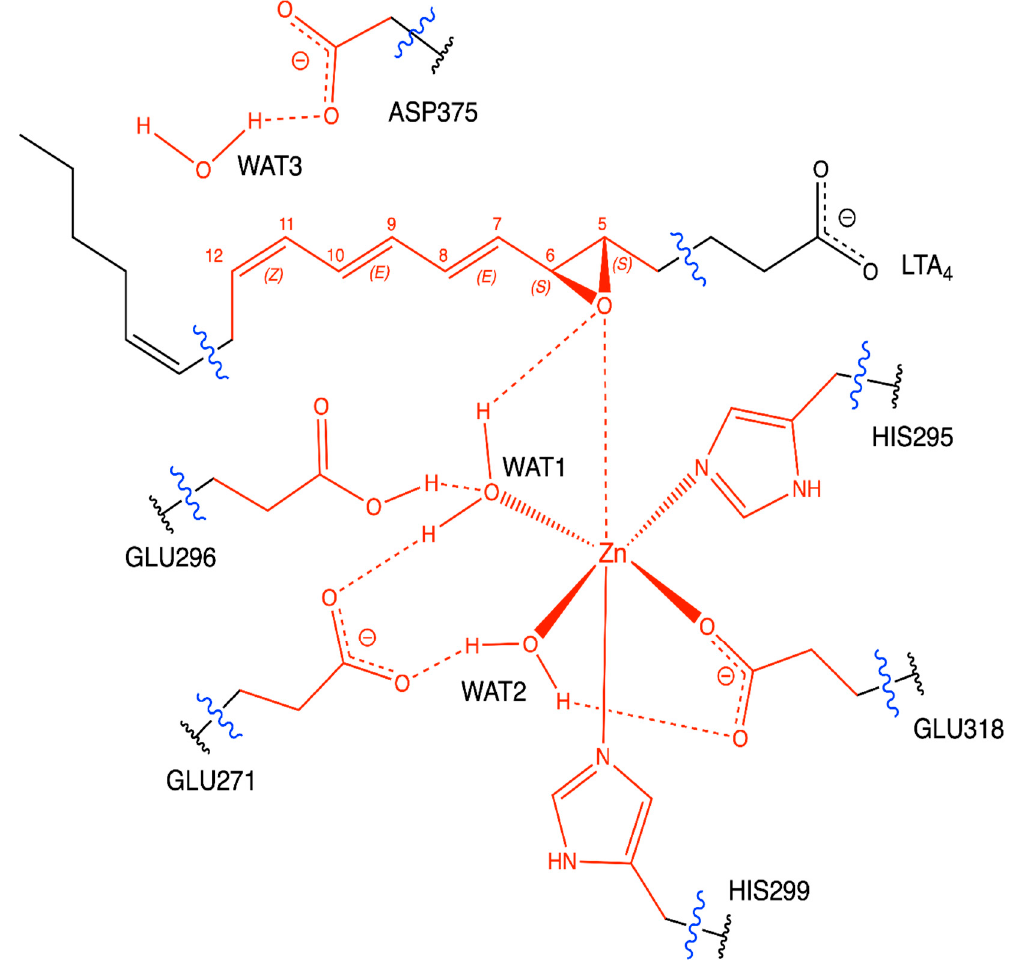
Figure 2. QM/MM partition. QM atoms are depicted in red. The boundary between the QM and MM regions is indicated by blue wavy lines.